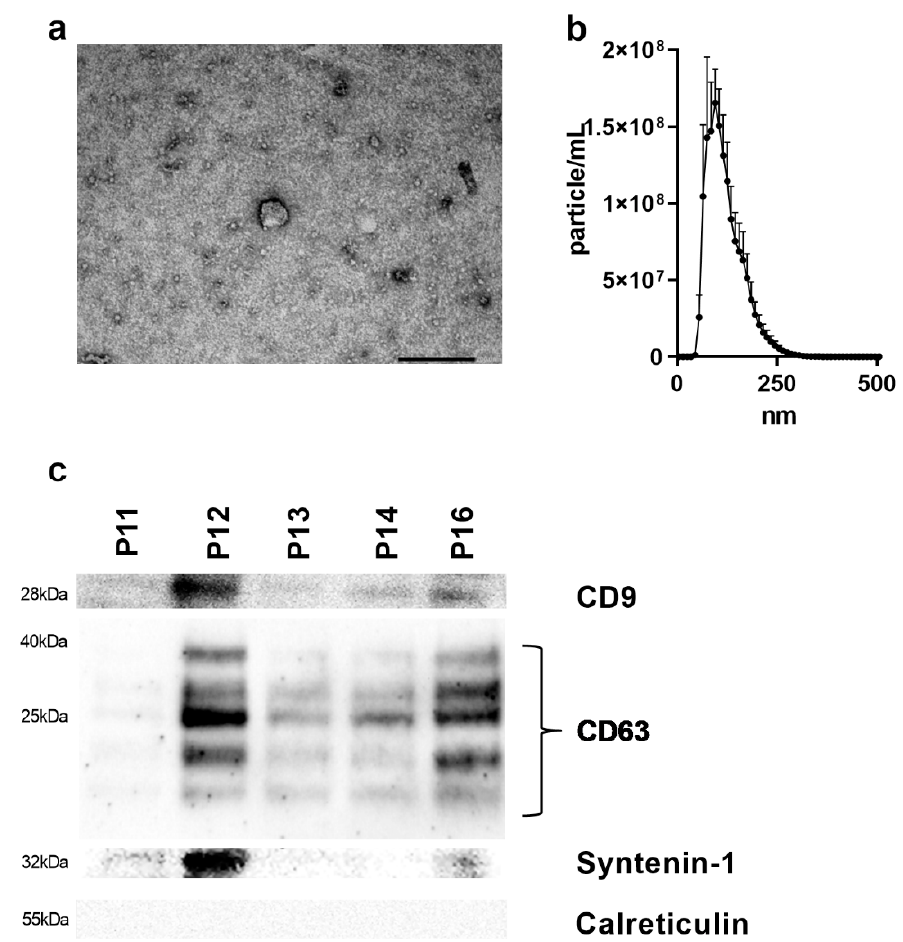
Figure 1. EV characterization of gastric cancer patients: ( a ) Visualization of plasma-derived EVs using TEM (scale bar; 100 nm). ( b ) Representative analysis of the particle size from plasma EVs of gastric cancer patients by NTA ( n = 3). ( c ) Western blot analysis of CD9, CD63, syntenin-1, and calreticulin in EVs from GC patients (EV—extracellular vesicle; kDa—kilo Dalton; nm—nanometer; TEM—transmission electron microscopy).